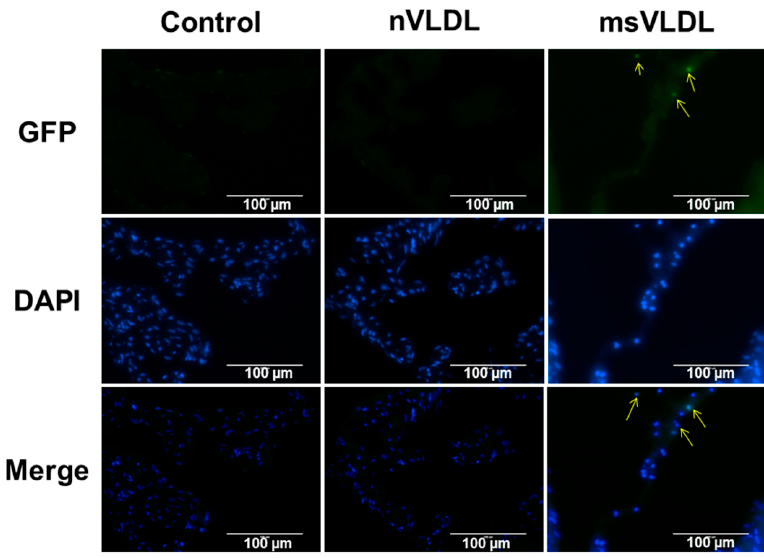
Figure 4. Apoptosis in atrial tissue of msVLDL mice. Representative in situ terminal deoxynucleotidyl transferase (TUNEL) staining of atrial tissues from control ( left ), nVLDL ( middle ), and msVLDL ( right ) ( n = 3 for each groups). Normal nuclei with DAPI staining appear blue. Condensed or fragmented nuclei appeared bright green and indicate cells undergoing apoptosis. Arrows indicate apoptotic atrial myocytes in the msVLDL group. The scale bars indicate 100 µm.